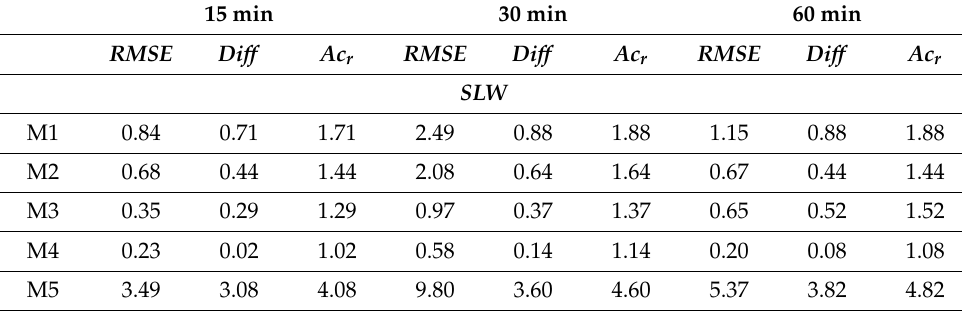
Figure 10. Comparison of liquid precipitation series at 60 min scale for low ( RLW ), medium ( RMW ) and high wind speed ( RHW ) groups. Values correspond to TPB measurements (black dashed line), Parsivel measurements (yellow line) and corrected precipitation with density model 1 (M1 in red line) and 5 (M5 in blue line). Scatterplots of Parsivel, M4 and M5 respect to TPB as reference were included. Dashed gray line shows m = 1 slope. For comparison purposes, we show only records without any precipitation one hour before to guarantee that the TPB was empty. Table 9. Root mean square error ( RMSE ), relative difference ( Diff ), and accumulated ratio ( Ac r ) between precipitation corrected with five density models and Parsivel measurements for three timescales. Scores are displayed for low ( SLW ), moderate ( SMW ), and high wind speed ( SHW ) groups of solid